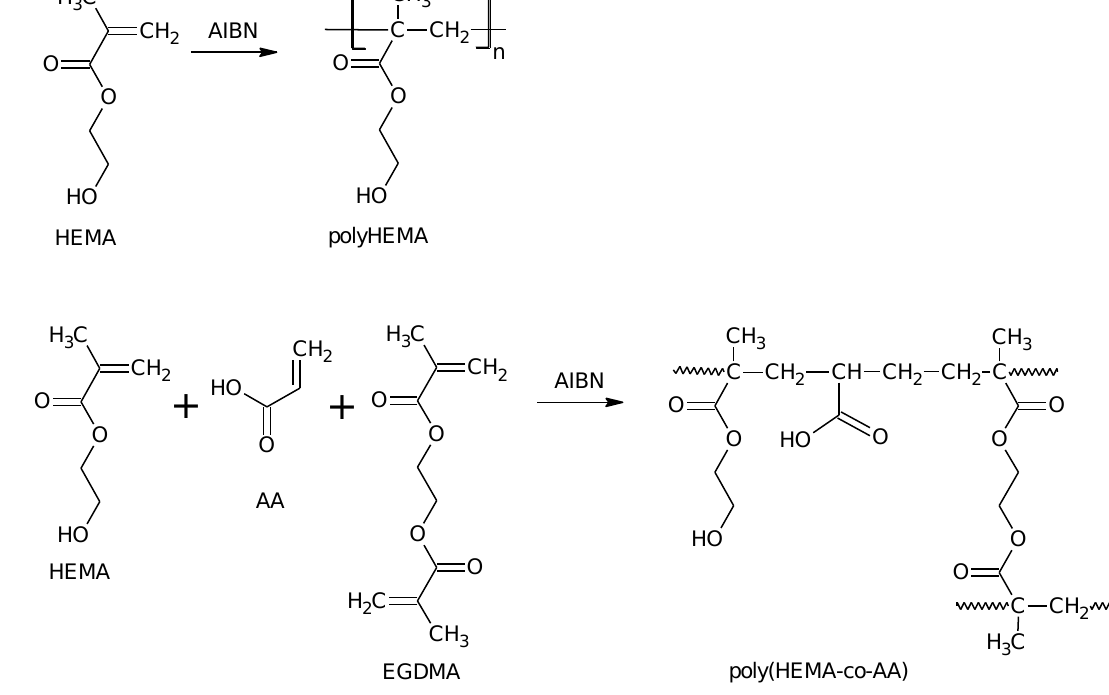
Scheme 1. The reaction scheme for the crosslinked polymers/hydrogel formation.